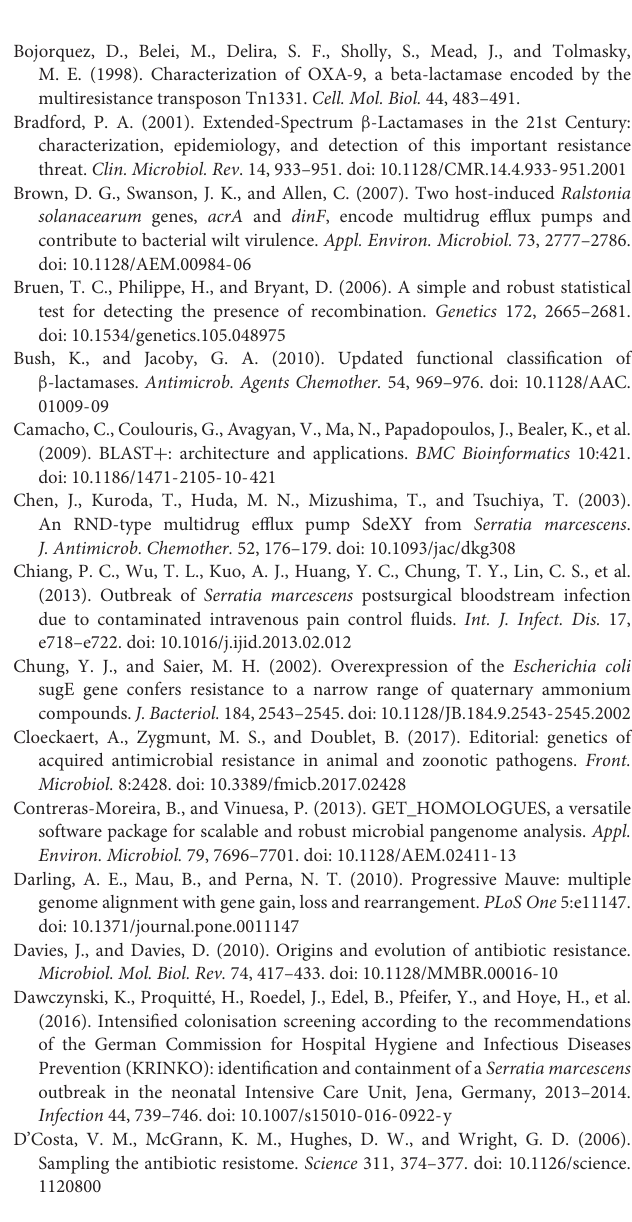
FIGURE S1 | Venn diagram of the consensus core-genome of the 32 Serratia spp. genomes generated by COG, OMCL, and BDBH algorithms. FIGURE S2 | Pairwise core-genome average nucleotide identity values from OMCL clusters (cgANIb-OMCL). The colors in the heat map represent pairwise ANI values, with a gradient from light yellow (high identity) to red (low identity).